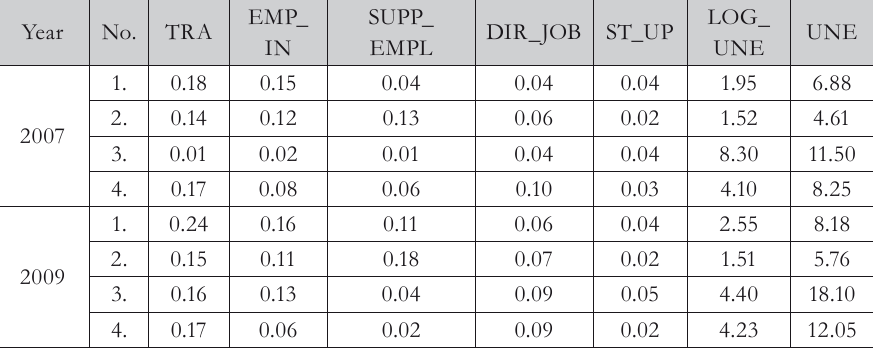
Tab. 1 – Average values of variables from clusters in 2007 and 2009. Source: Own